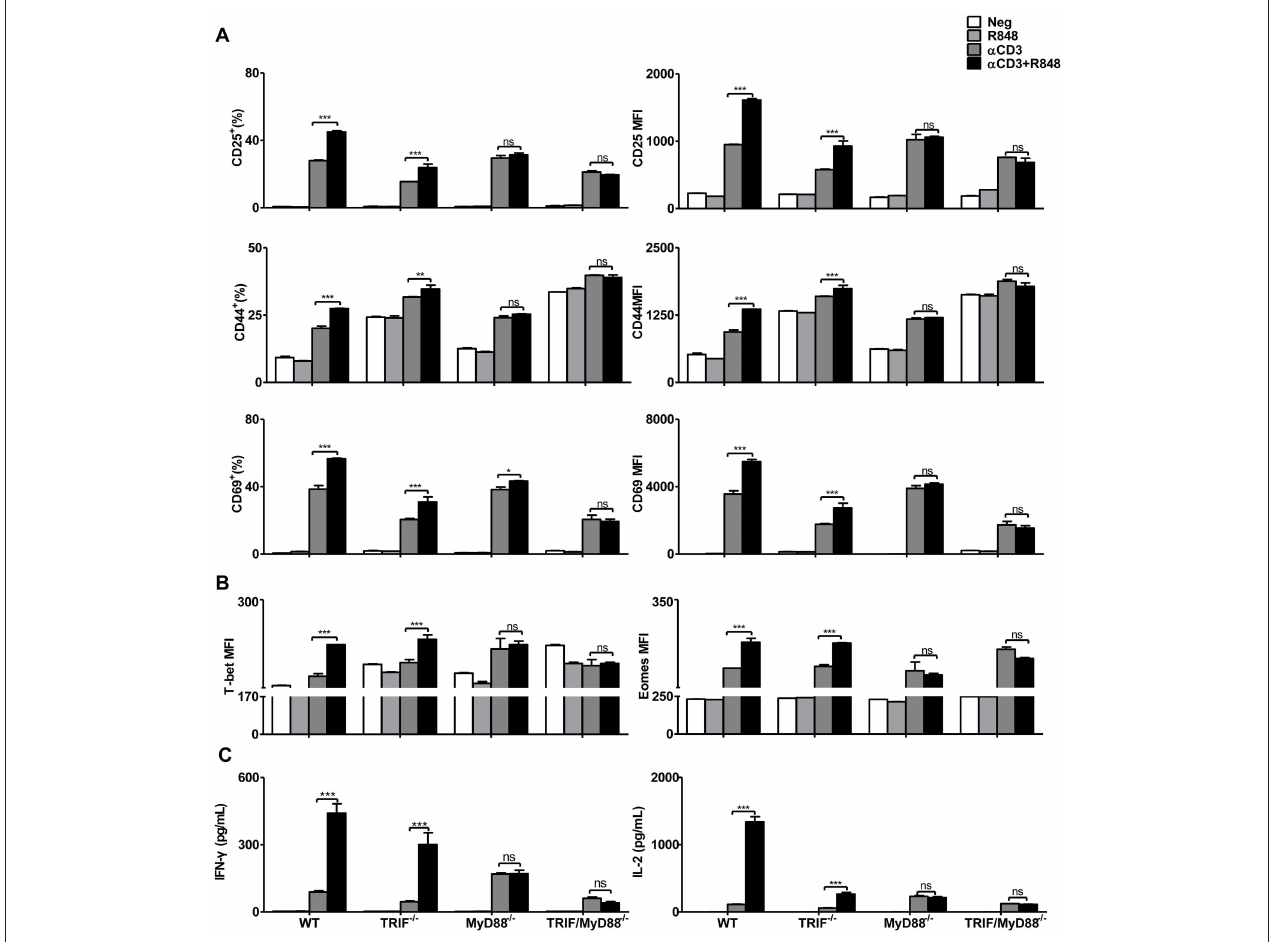
FIGURE 2 | Enhancement of the effector function of CD8 + T cells mediated by TLR7 agonists is MyD88-dependent. Purified CD8 + T cells from WT, TRIF − / − , MyD88 − / − , and TRIF/MyD88 − / − mice were stimulated in plates with bound α CD3 antibody (5 µ g/mL) alone or with R848 (10 µ g/mL) for 24h. CD25, CD44, and CD69 (A) , T-bet and Eomes (B) expression in CD8 + T cells were analyzed by flow cytometry. (C) Cytokines production including IFN- γ and IL-2 was detected by specific ELISAs. Data are representative of two independent experiments. All data are presented as mean ± SD. The statistical relevance was determined by Two-way ANOVA: * p < 0.05; ** p < 0.01; *** p < 0.001; ns, not